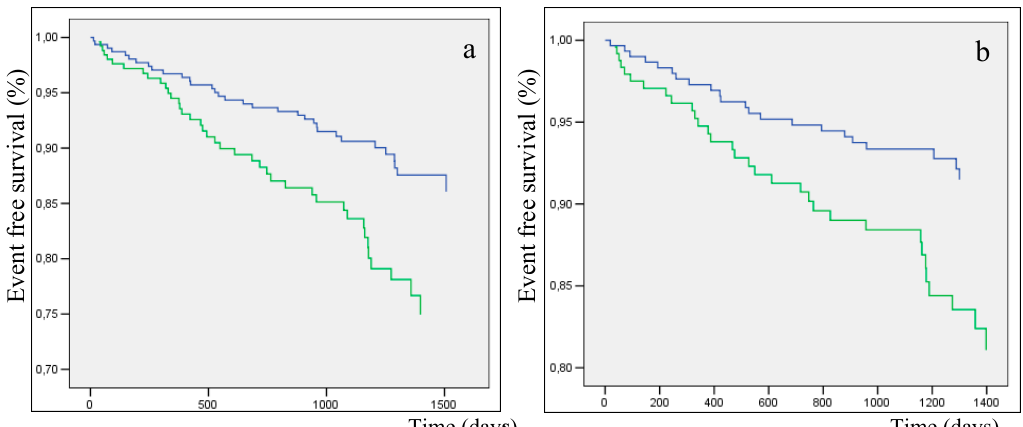
Figure 1. Plots of the Cox regression model. Panel ( a ) shows event-free survival for primary endpoint in patients with (lower line) or without (upper line) previous MACES according to variables entered in the Cox model (LV diastolic function and TAPSE). Panel ( b ) shows event-free survival for secondary endpoint in patients with (lower line) or without (upper line) previous MACES according to variables entered in the Cox model (TAPSE).